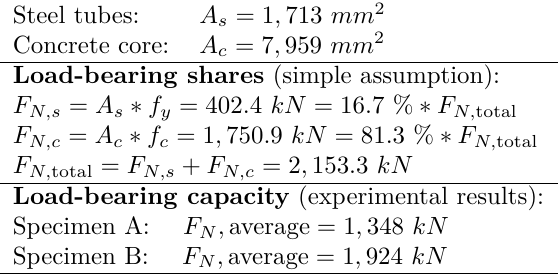
Table 6. Maximum load-bearing capacity